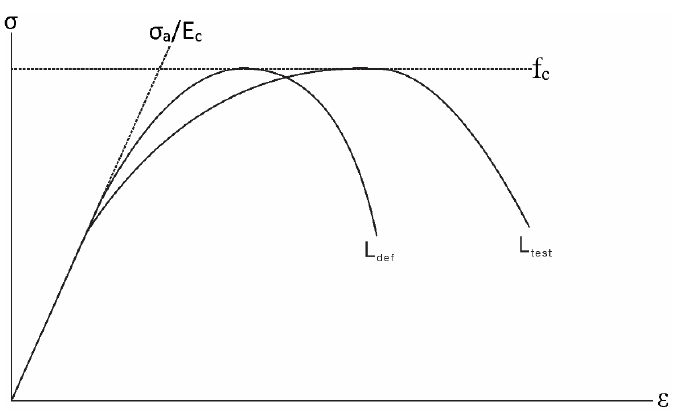
Figure 4. Compression of concrete in hinges.